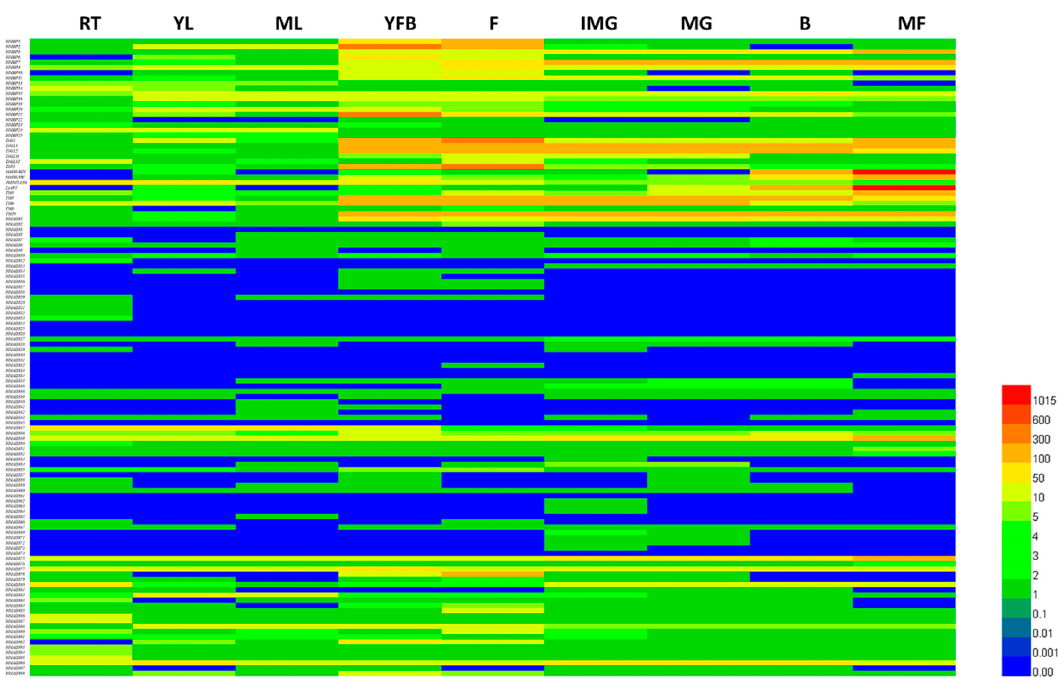
Figure 4. Heat map representation of tomato MADS-box genes in various tissues. The tissues included the whole root (Rt), young leaf (YL), mature leaves (ML), young flower buds (YFB), and fully open flowers (F), which were at the immature green (IMG), mature green (MG), break (B), and mature (MF) stages of fruit development and ripening. The bar at the bottom of the heat map represents relative gene expression values.